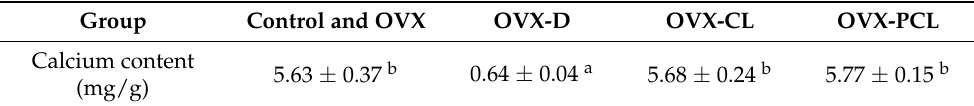
Table 1. Calcium content in diets (mean and standard